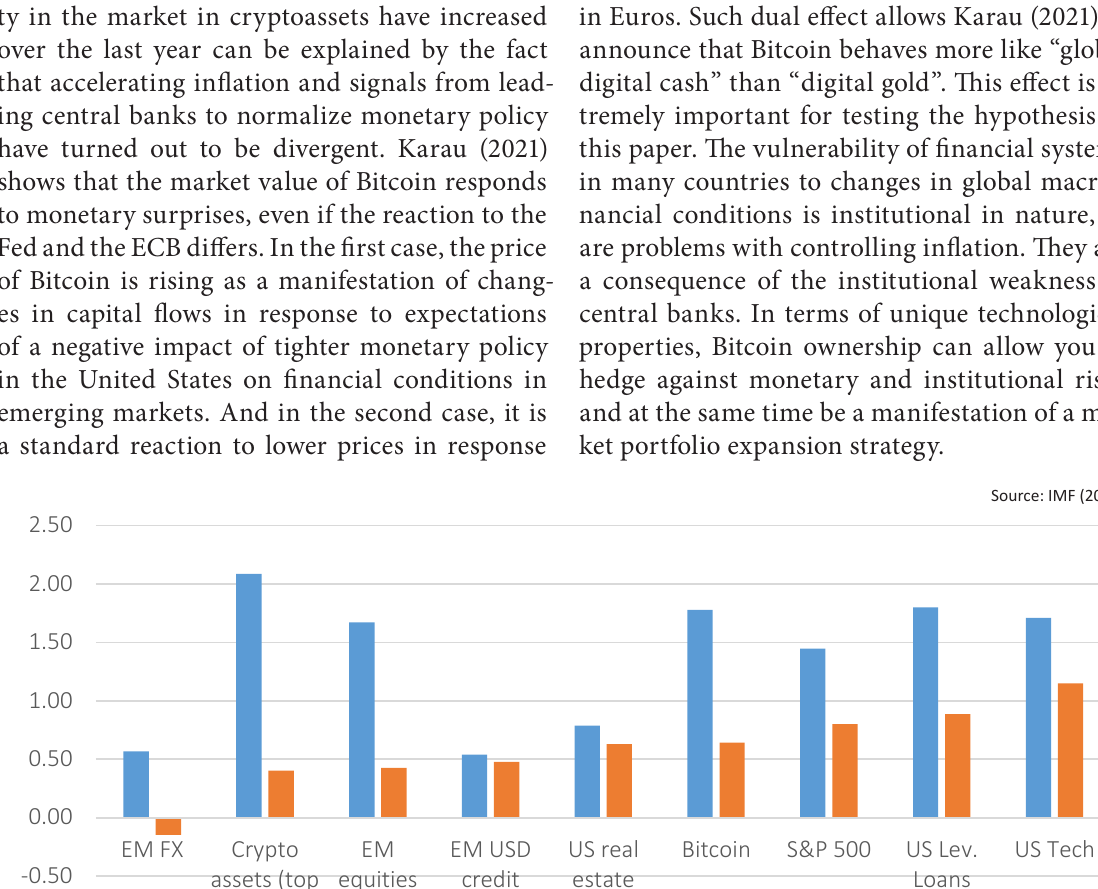
Figure 4. Commodity price index and Bitcoin